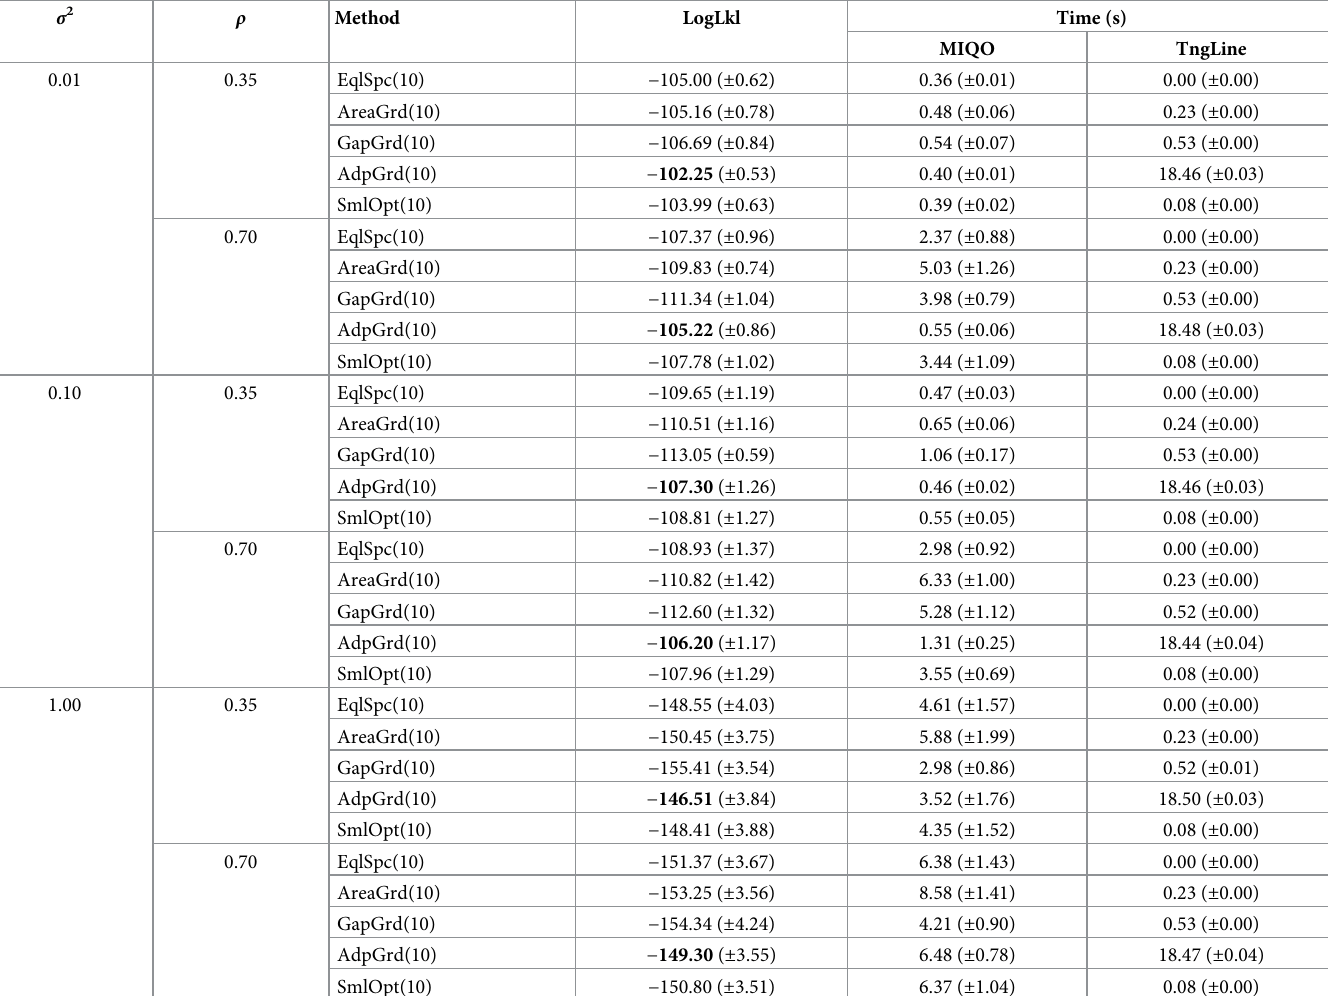
Table 2. Results of our MIQO formulation for synthetic training instances ( θ = 10). σ